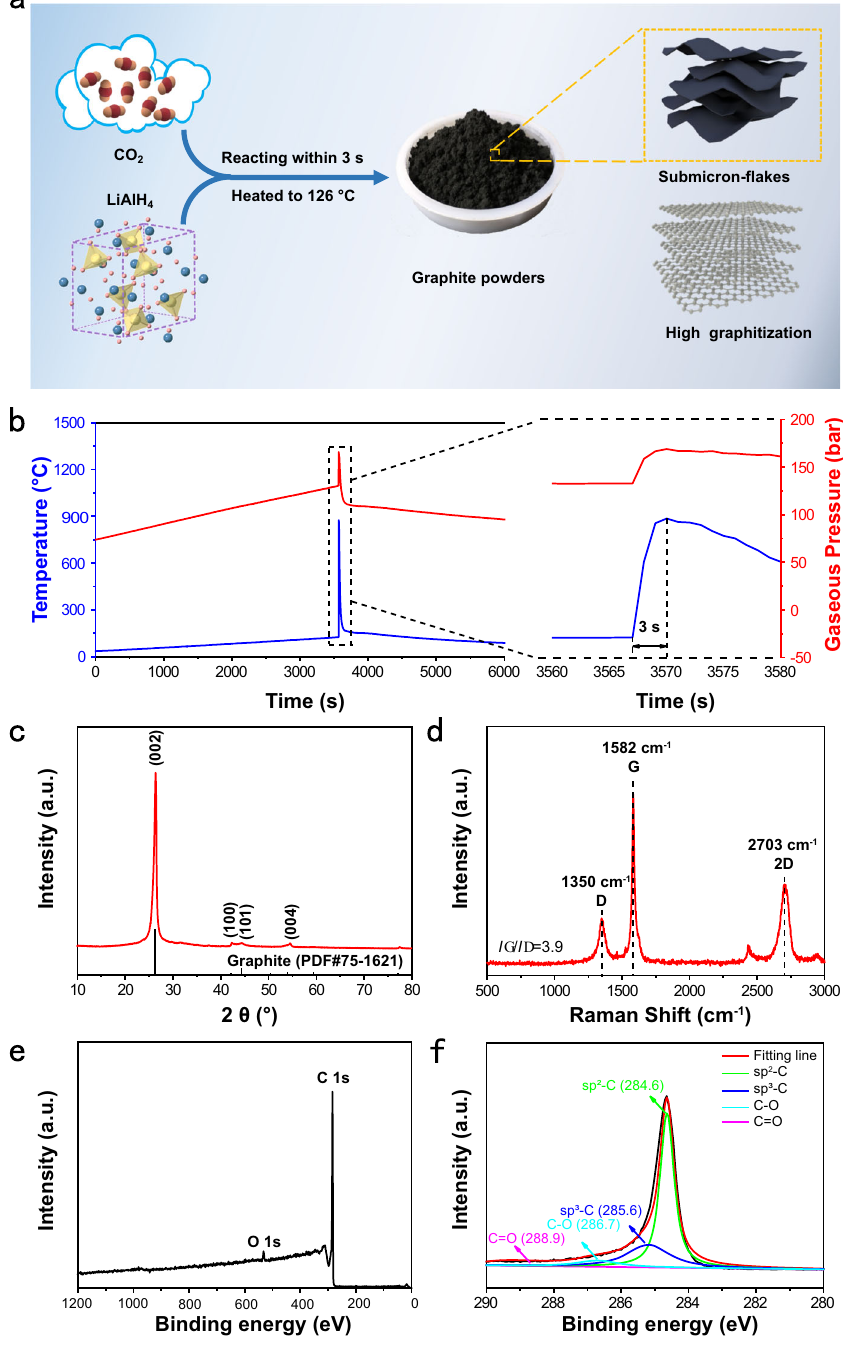
Fig. 1 The synthesis and characterization of graphite derived from CO 2 . a Schematic illustration of the synthesis of graphite submicro fl akes. b Time dependence of temperature and gas pressure in the reactor during the reaction process. c XRD pattern of the solid products after reaction. d Raman spectrum of the solid products after the removal of impurities. e XPS survey spectrum of graphite submicro fl akes. f High-resolution XPS spectrum of C 1